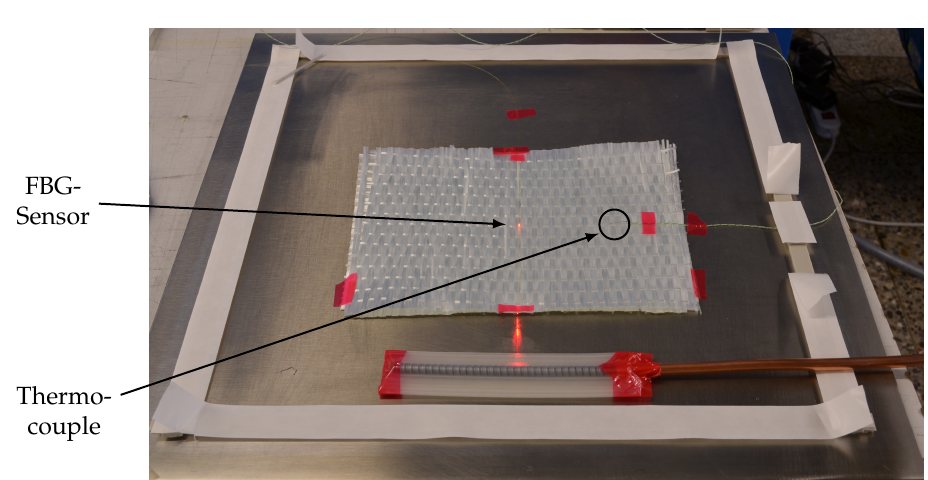
Figure 2. Top view of the experimental set-up in the plane of